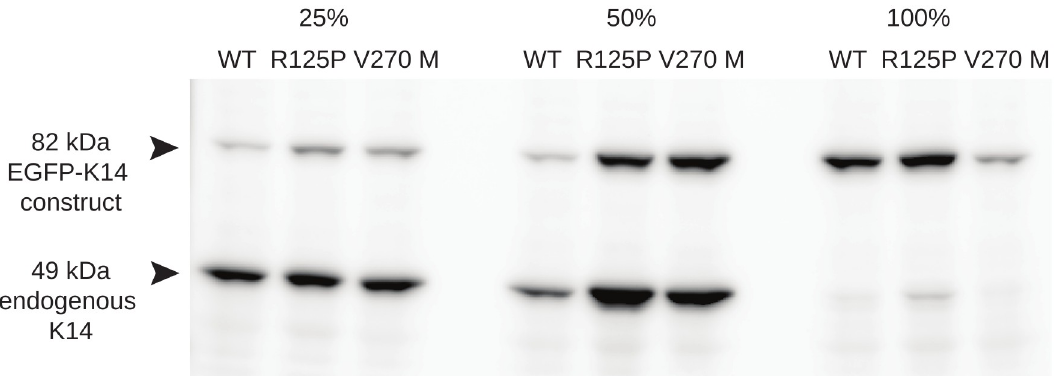
Fig 4. Western blot analysis of selected EGFP-K14 (WT or mutant) clones. The upper band belongs to the fluorescently labeled K14 protein, while the lower band to the unlabeled endogenous K14 WT. The numbers 25%, 50% and 100% indicate the ratio between EGFP-K14 to endogenous K14 WT of the clones that were selected for further analysis.